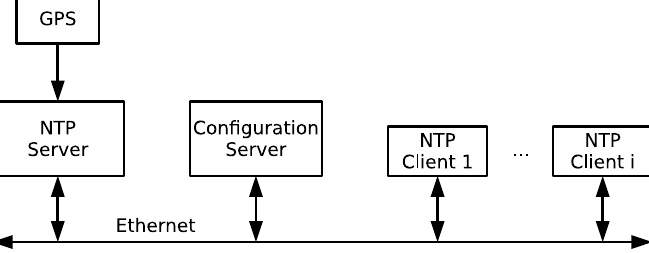
Figure 3. NTP synchronization system